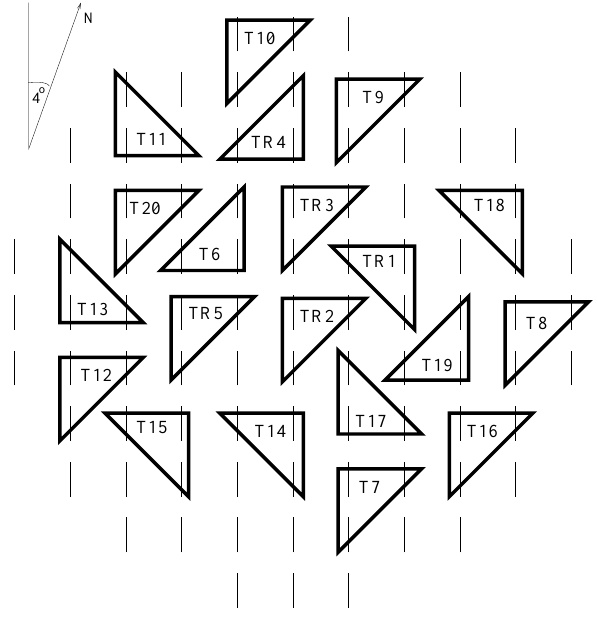
Fig. 1. North-south antenna configuration employed for Buckland Park MF radar from 20 December 2001 to thepresent. Each ver- tical line represents a single north-south aligned antenna. The tri- angles denote the antennas used for observations, and the appro- priate transmit channel. Antenna groups denoted TR i and T i were connected to transmitter i . Antenna groups denoted TR i were con- nected to receiver i via T/R switch i